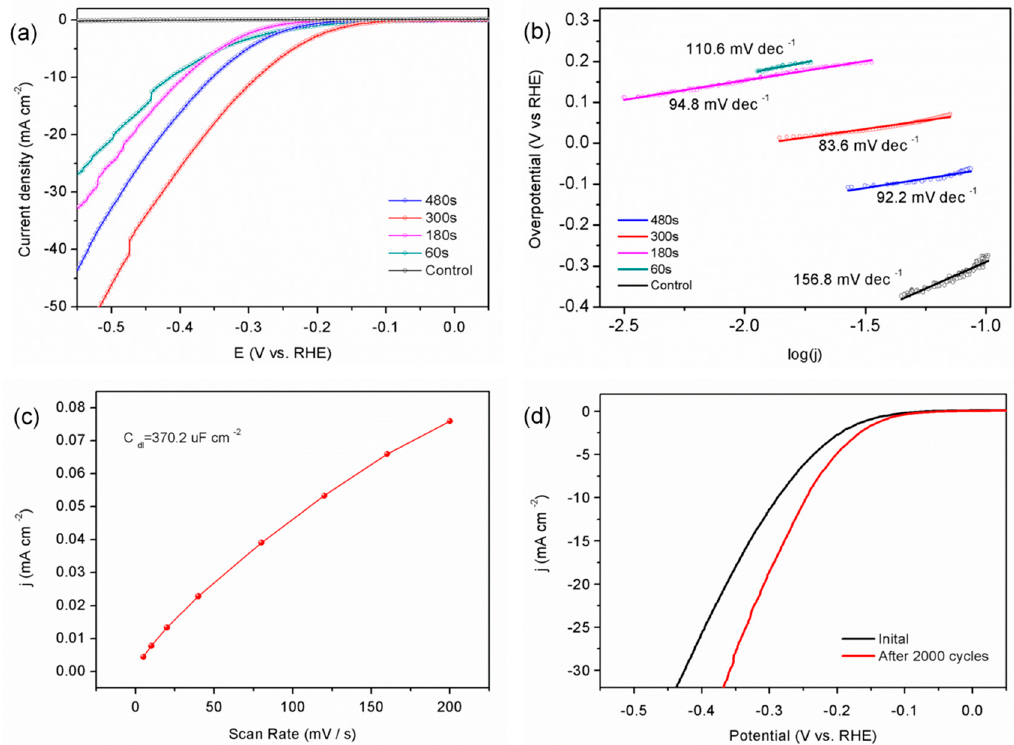
Figure 4. ( a ) Hydrogen evolution reaction (HER) polarization curves and ( b ) corresponding Tafel plots of the different catalysts; ( c ) double-layer capacitance (C dl ) and ( d ) polarization curves before and after 2000 cycles of the N 2 plasma 300 s sample.